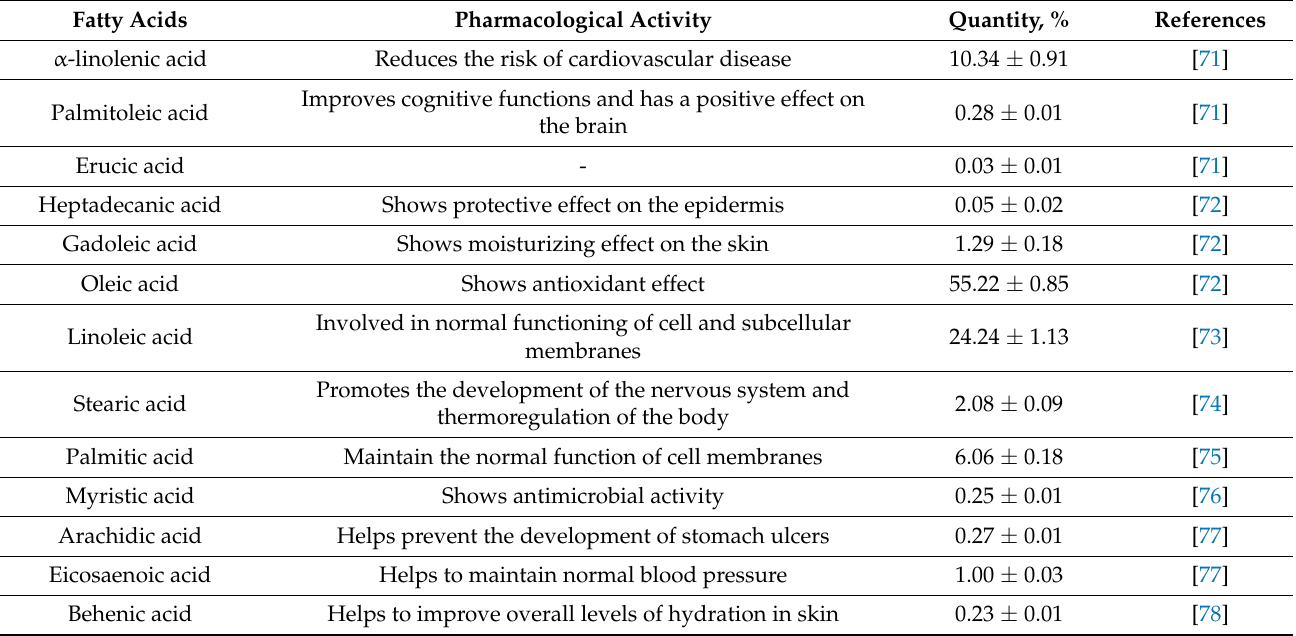
Table 2. Fatty acid composition of rapeseed